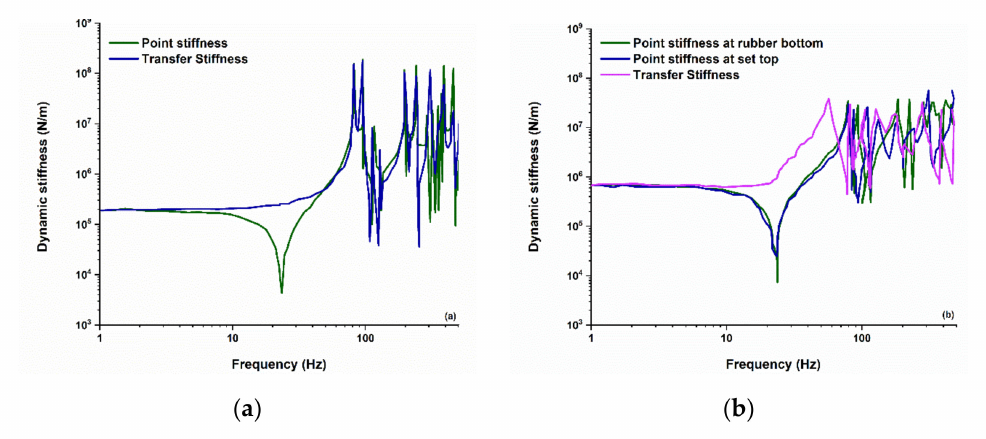
Figure 10. Dynamic stiffness of spring set: ( a ) spring set; ( b ) spring set with